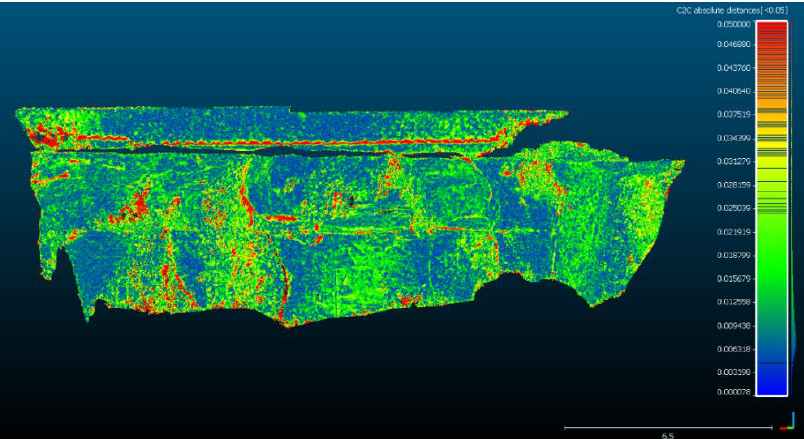
Figure 7. Colour map of absolute distance differences between the TLS model and the block T2.5 photogrammetric digital model in the range of 5 cm for T2.